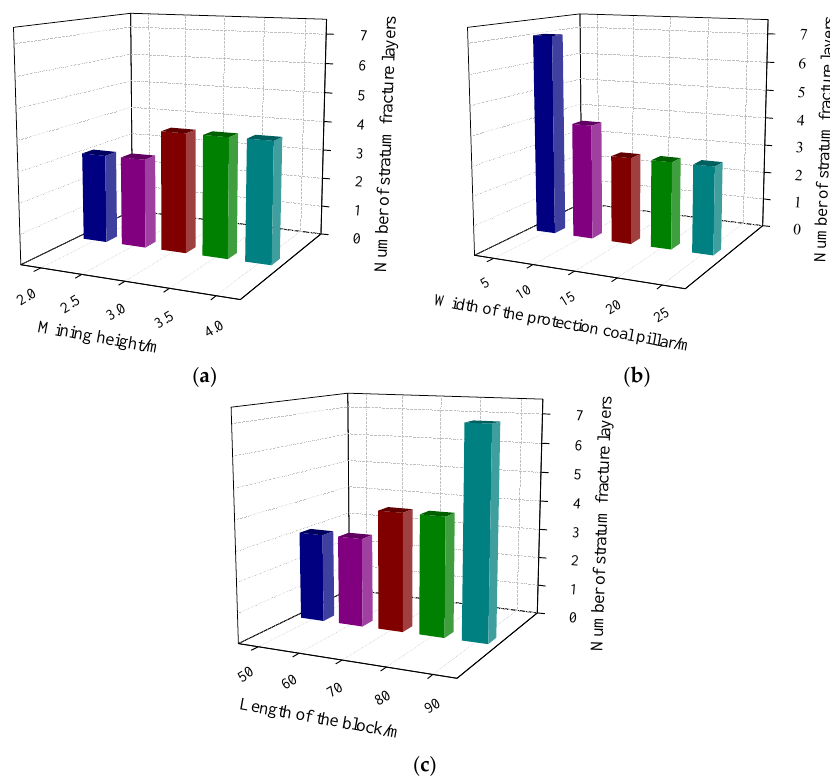
Figure 10. Variations in the number of stratum fracture layers with different effecting factors: ( a ) variation in the number of stratum fracture layers with mining height; ( b ) variation in the number of stratum fracture layers with the width of the protection pillar; and ( c ) variation in the number of stratum fracture layers with block length.